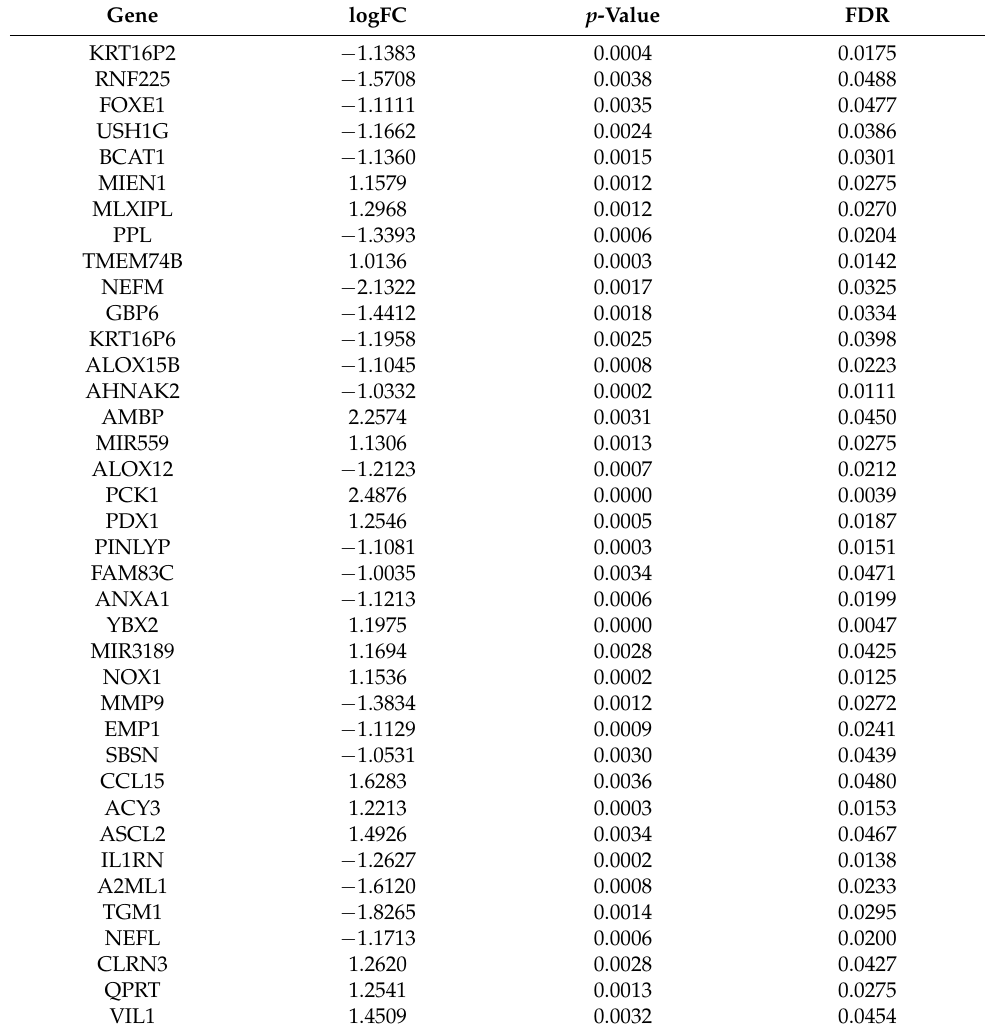
Table 2. Differentially expressed genes between high and low-risk groups. Gene logFC p